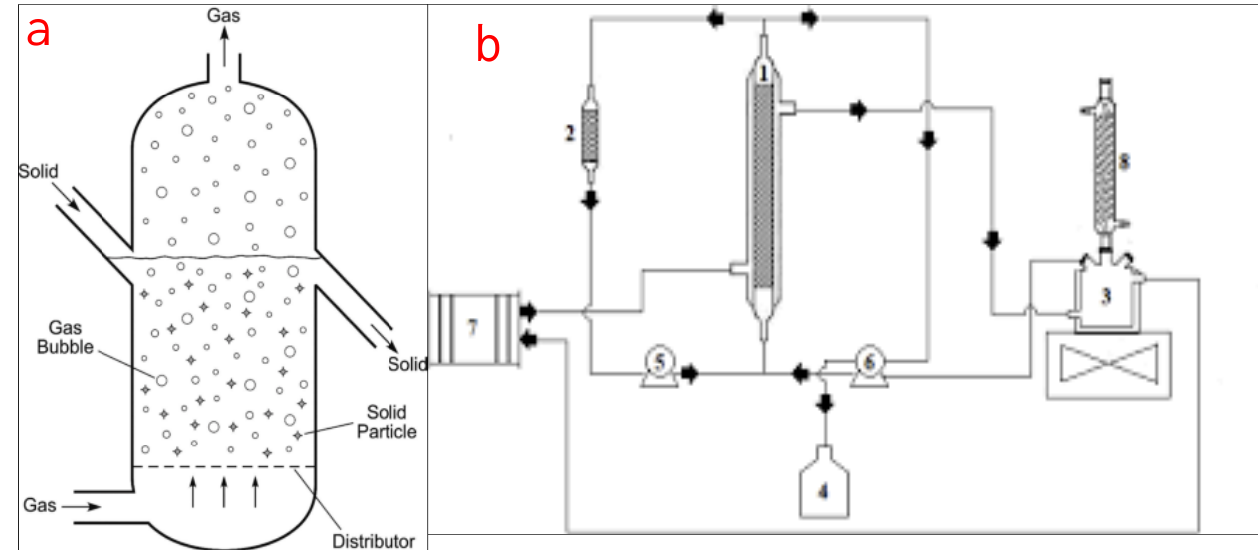
Figure 10. ( a ) schematic representation of a fluidized bed reactor; ( b ) a typical fluidized bed reactor for biodiesel production. (1 = reactor; 2 = reactor column; 3 = substrate reservoir; 4 = product vessel; 5 and 6 = peristaltic pumps; 7 = thermostatic bath; 8 = reflux condenser). Adapted from [75].